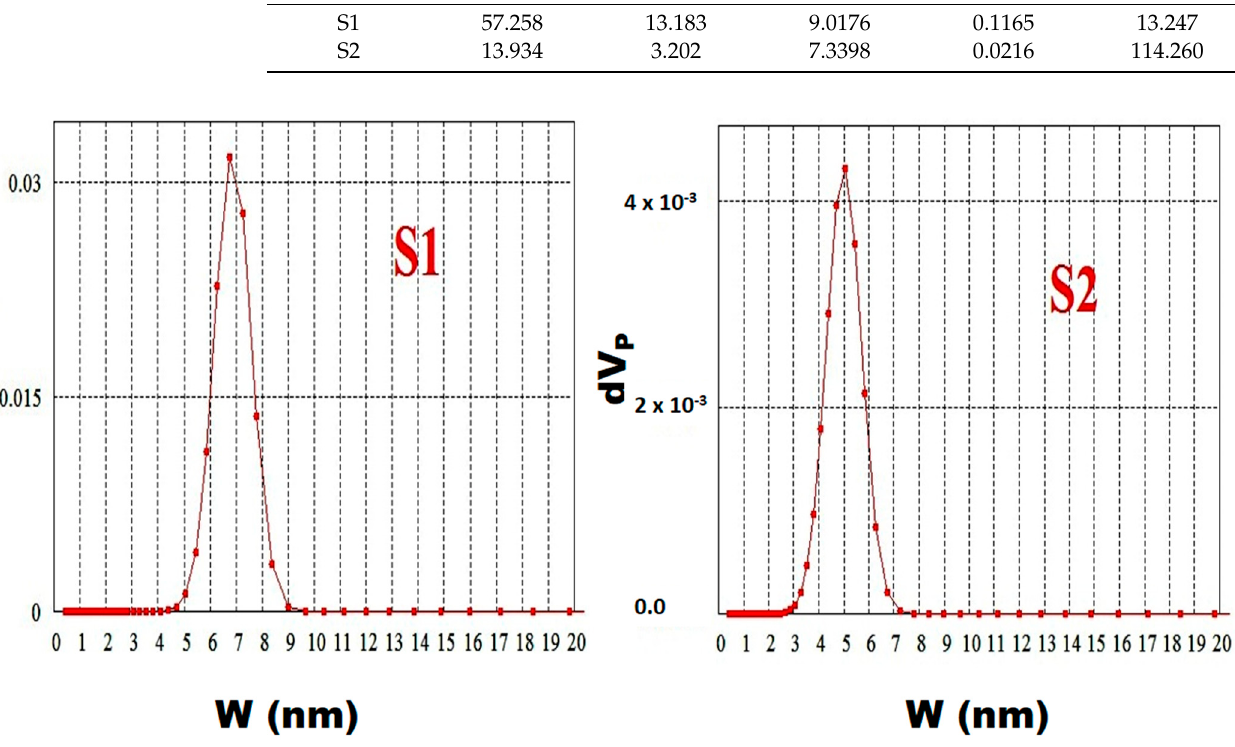
Table 2. Surface properties of the S1 and S2 samples. Table 2 . Surface properties of the S1 and S2 samples .